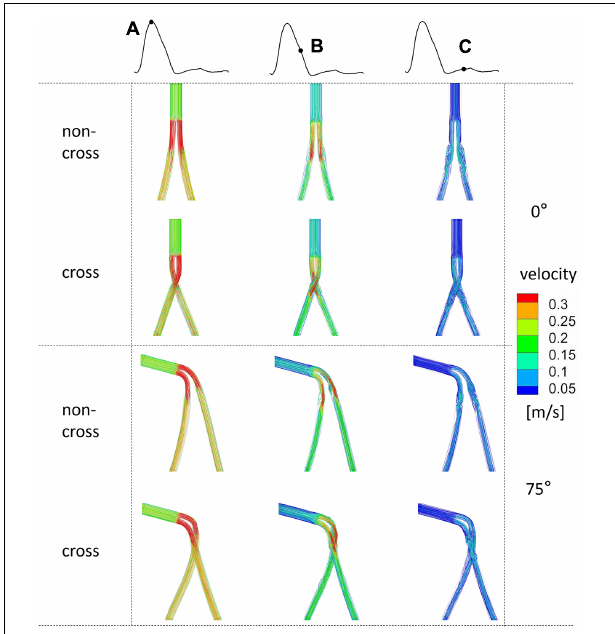
FIGURE 4 | The flow chart of the systolic peak time of the ideal model with 0 ◦ and 75 ◦ coronal planes and different colors indicates different velocities. Mark (A) for systolic peak, (B) for late deceleration, and (C) for early